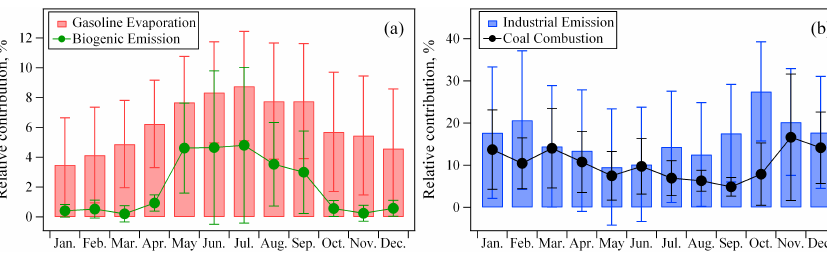
Figure 13. Monthly variations in the average relative contributions of (a) gasoline evaporation and biogenic emissions and (b) industrial emissions and coal combustion at 27 sites in Beijing. The error bars reflect one standard deviation from the average relative